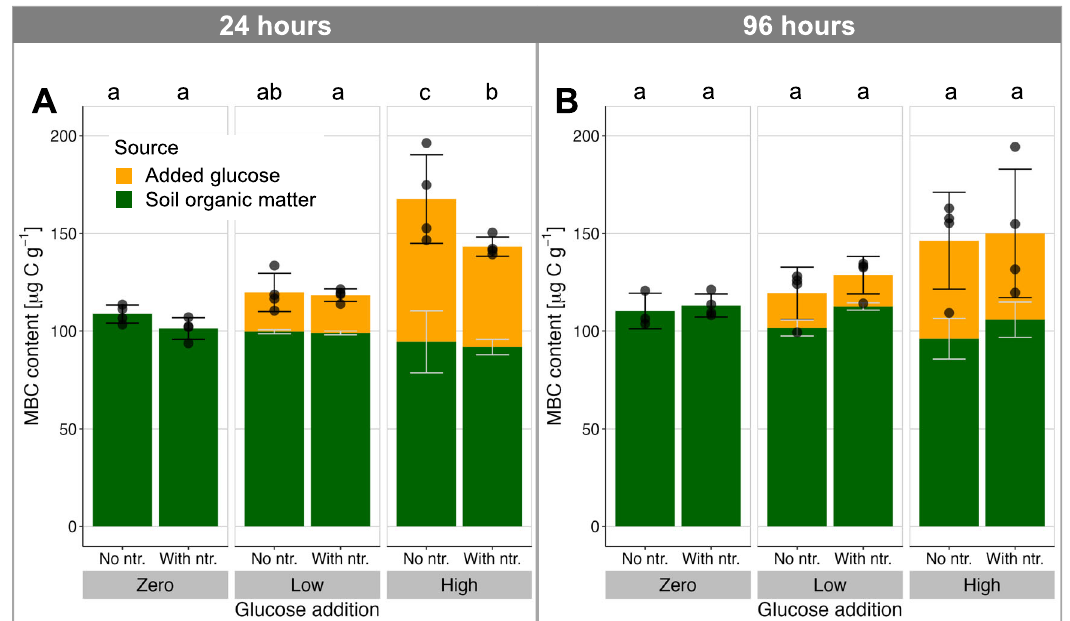
Fig. 3 | Extractable soil microbial biomass determined by chloroform fumigation-extraction. A 24h and B 96h after addition of a readily degradable, 13 C-labelled carbon source (glucose at 0, 90, and 400 µ gC g − 1 soil) with or without mineralnutrientsupply(ntr.;N,P,K,S).Theheightsofthebarsrepresentthemean ±standard deviation as black errorbars ( n =4 independent soil microcosms except for one treatment with n =3: zero glucose, no nutrients at 96h). Contrasting